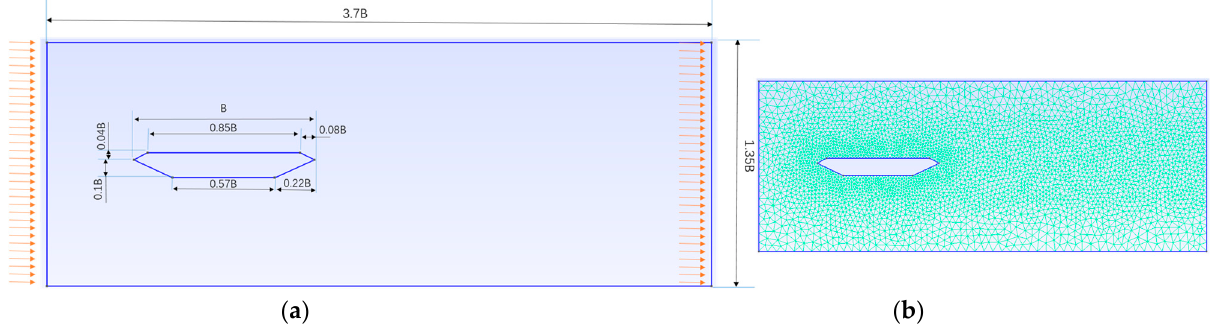
Figure 3. Geometric dimensions of fl uid fl ow past a generic bridge deck section: ( a ) Geometric dimensions; ( b ) Mesh distribution.